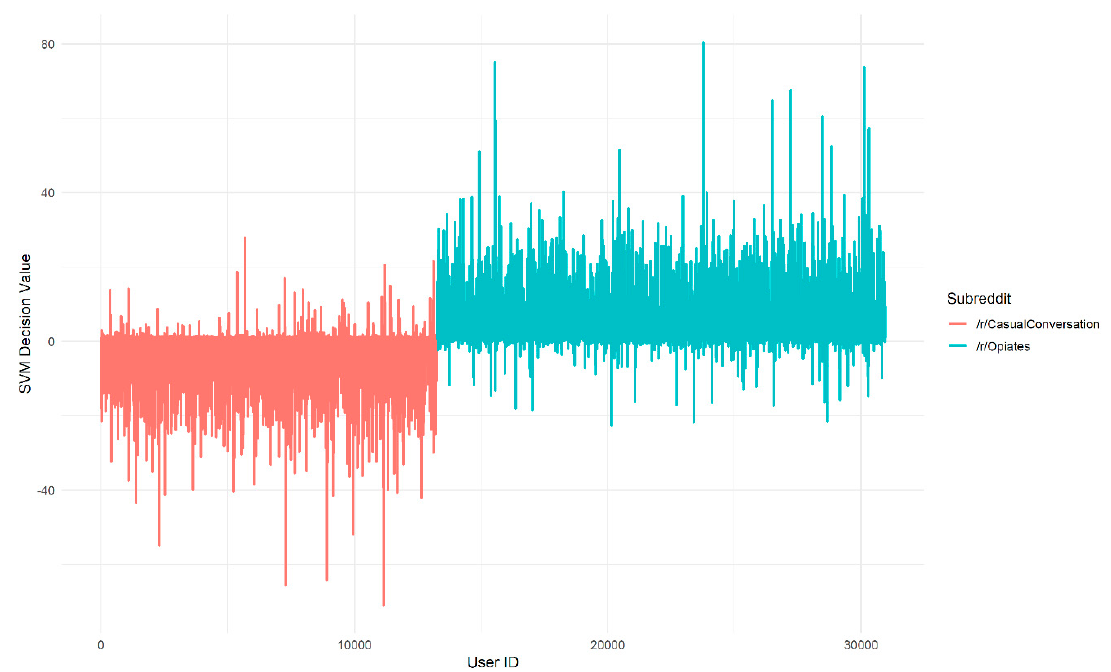
Figure 5. Decision values produced by a Linear SVM for author vectors trained with the /r/Opiates GloVe embedding, colored by subreddit of origin. A large magnitude of decision values corresponds to a large distance from the decision boundary of the SVM. The x-axis is an arbitrary user ID assigned to an author vector from /r/CasualConversation (left) or /r/Opiates (right).